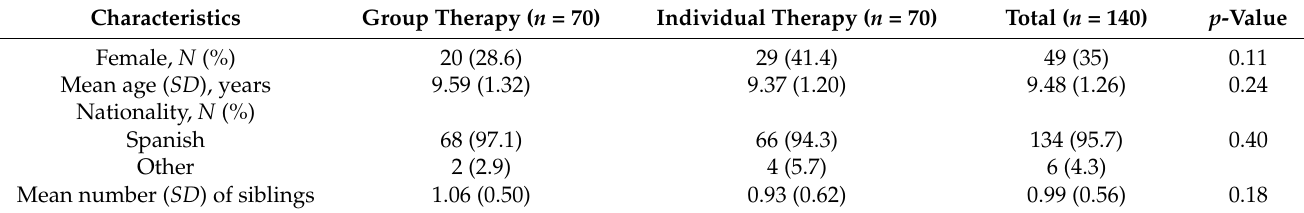
Table 1. Sociodemographic characteristics at baseline of participating children by intervention modality. Characteristics Group Therapy ( n = 70) Individual Therapy ( n = 70) Total ( n = 140) p -Value Female, N